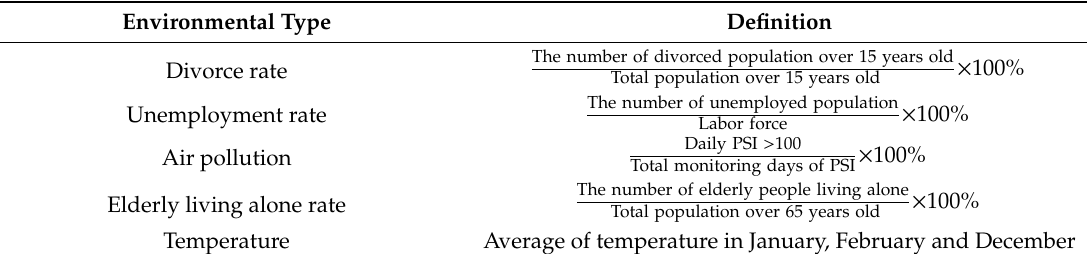
Table 3. Variable